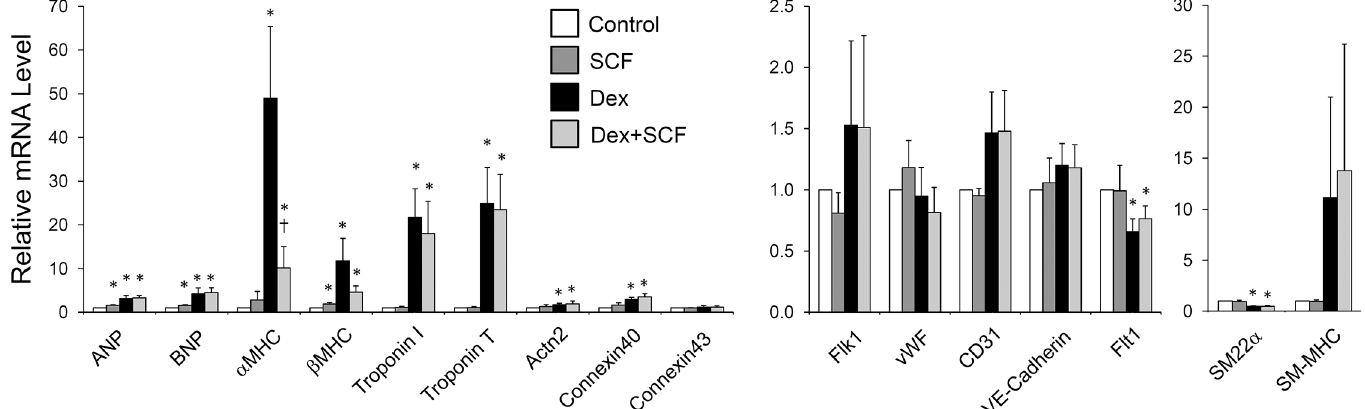
Fig 6. The effect of c-kit activation on cardiac differentiation of CPCs. Murine c-kit+ CPCs were induced to differentiate in dexamethasone-containing media as described in Materials and Methods. Cells in the first two groups were incubated in serum reduced media without dexamethasone and treated either with (SCF) or without (Control) SCF. The latter two groups were treated with 10 nM dexamethasone in the presence (Dex+SCF) or absence (Dex) of SCF. The mRNA levels of indicated cardiac markers were assessed by qPCR. * , p < 0.05 compared to the Control. † , p < 0.05 compared to the Dex only treatment